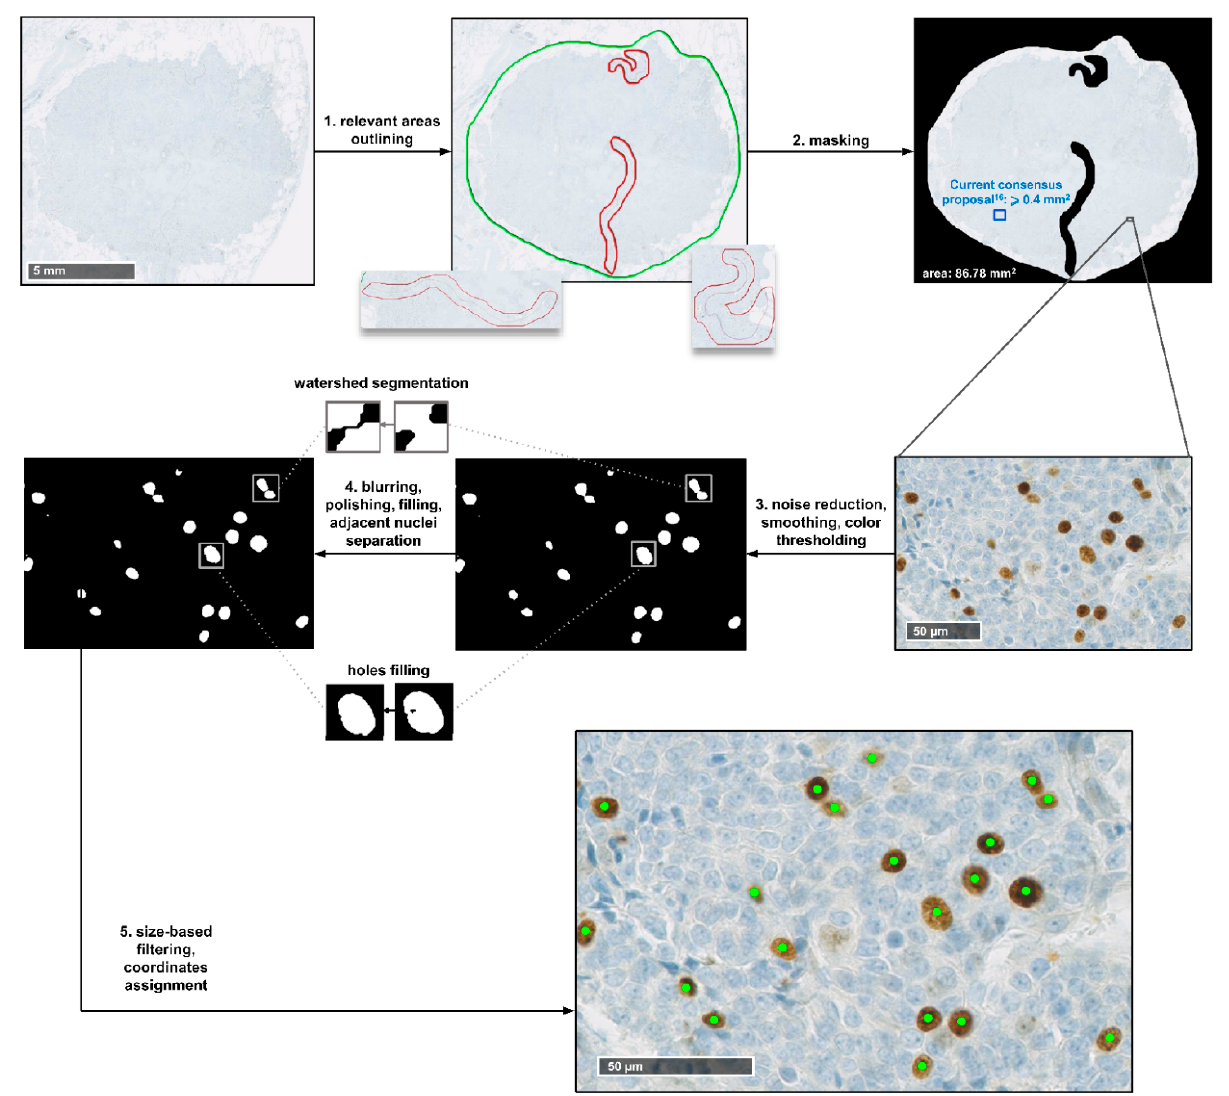
Figure 3. Visual representation of the pipeline of identification of Ki ‐ 67 + cells in the WSIs.